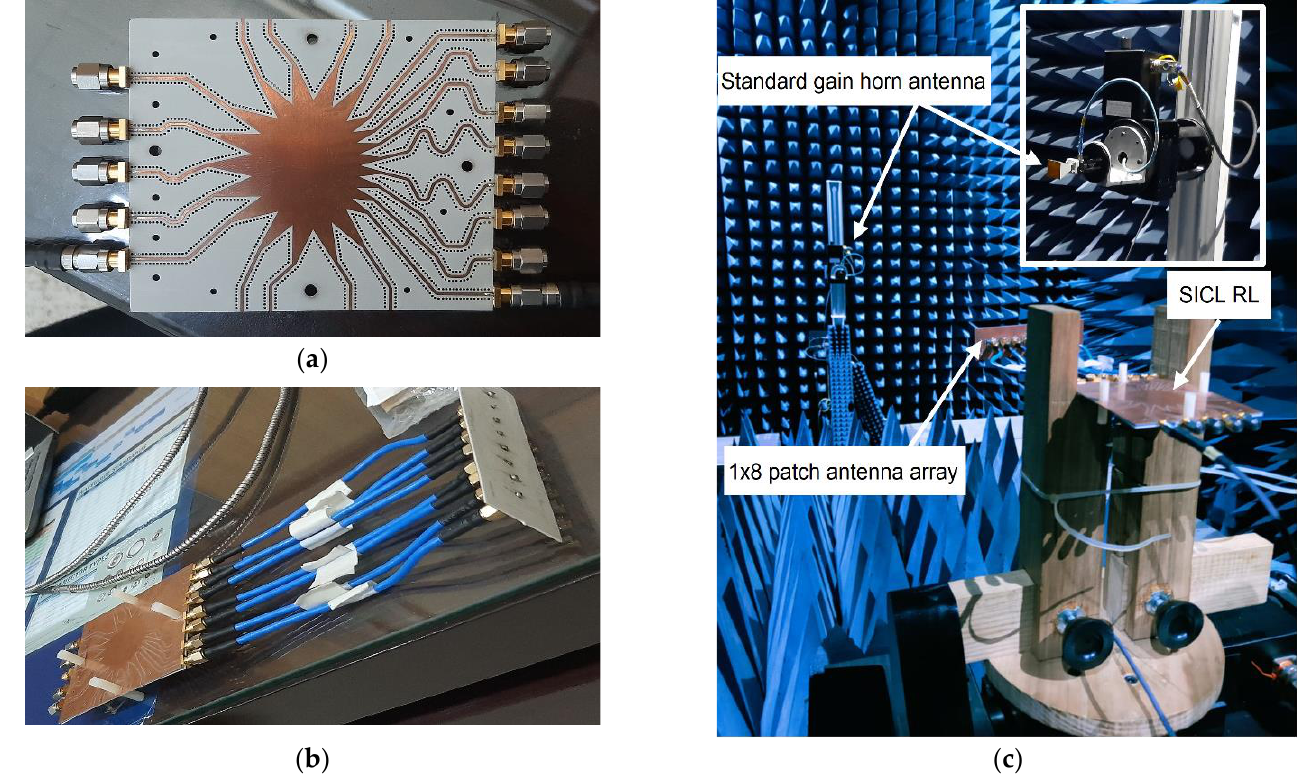
Figure 9. ( a ) Fabricated SICL Rotman lens (upper conductor layer removed); ( b ) integration with 1 × 8 antenna array; ( c ) test fixture in Anechoic Chamber for radiation pattern measurements.